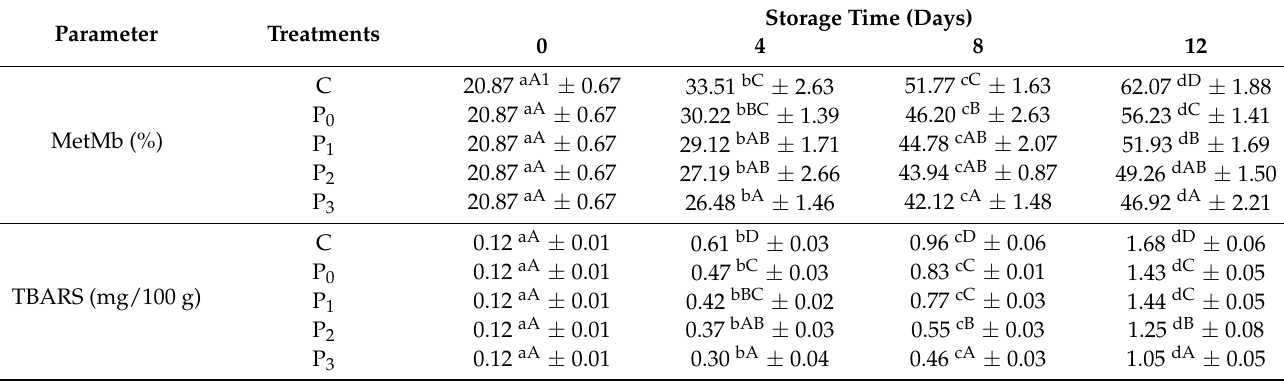
Table 3. Effect of the applied coatings on the chemical parameters of pork loins during storage.